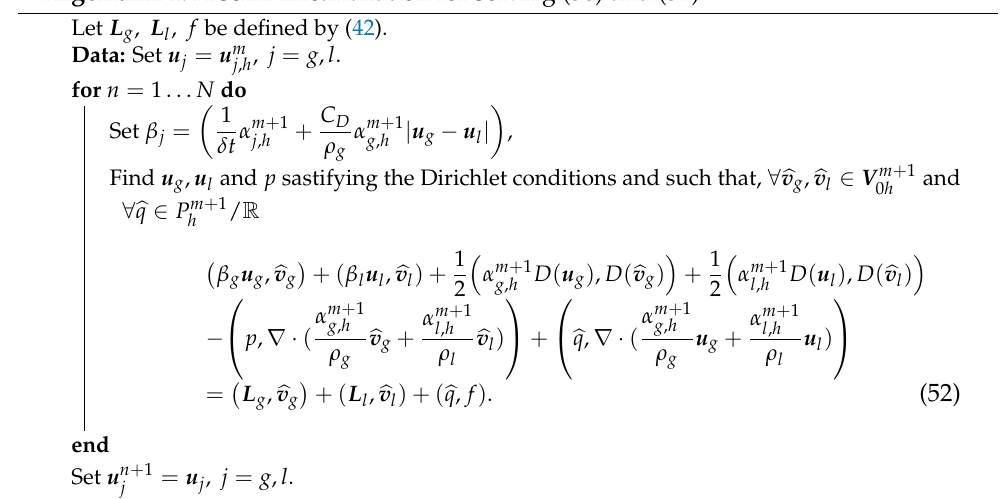
Algorithm 1: A semi-lineariazation for solving (50) and